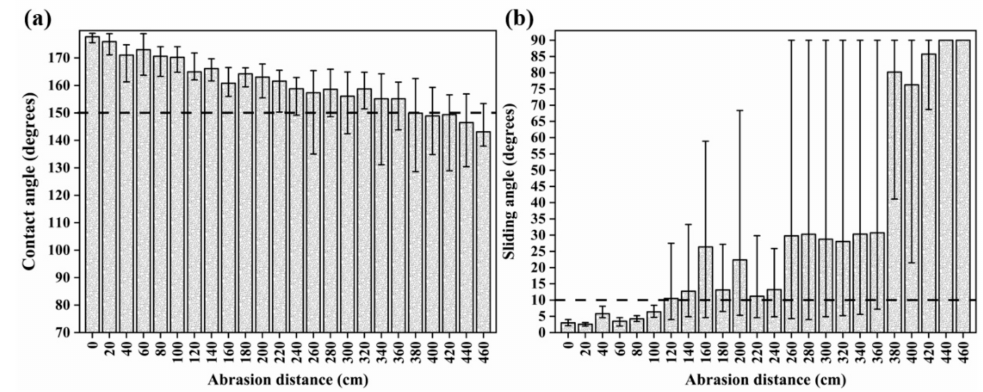
Figure 10. Results of the sandpaper scratch test on the fabricated superhydrophobic coated films with a relative SNP weight ratio of 100%: ( a ) CA and ( b ) SA.